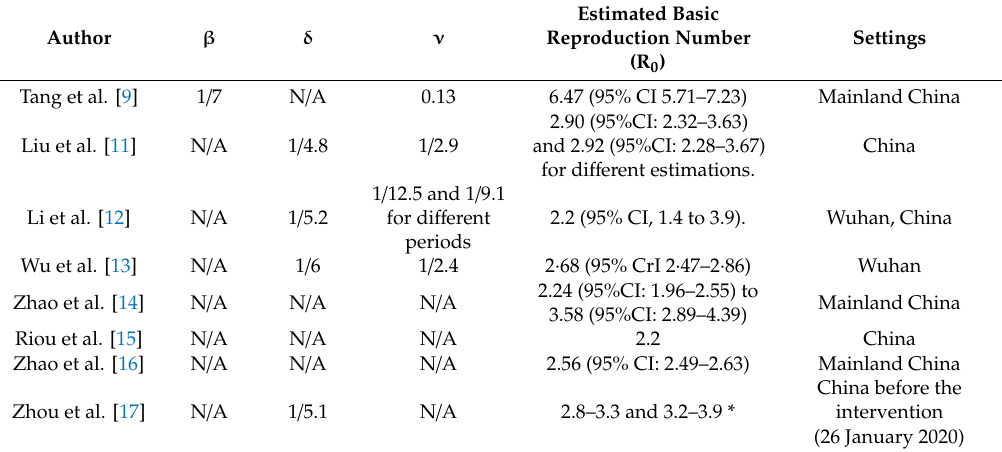
Table 1. Published estimation of basic reproductive numbers and available parameters of 2019-nCov and their settings (as of 16 February